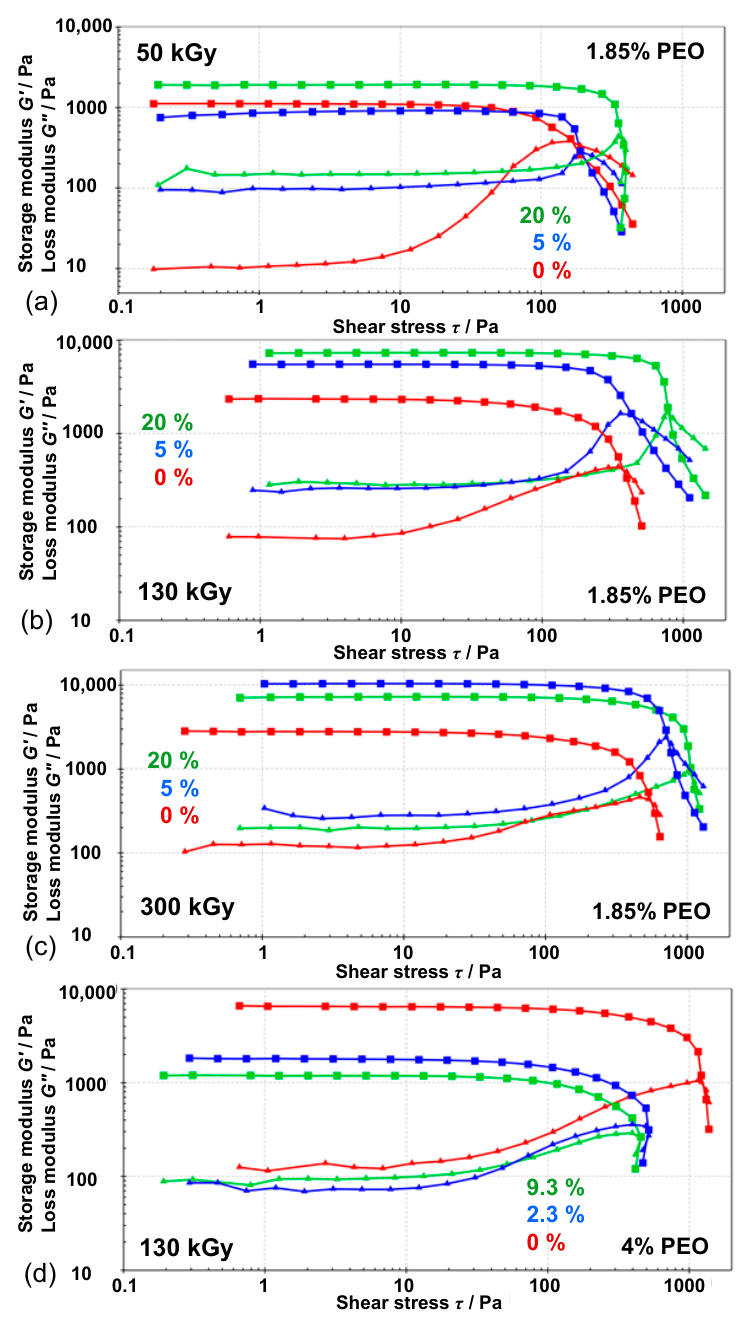
Figure 12. Amplitude sweep test ( G ′ ( ■ ) and G ″ ( ▲ ) values) of pure PEO gels and nanocomposite gels obtained at ( a ) 50 kGy, ( b ) 130 kGy, and ( c ) 300 kGy from 1.85 wt% PEO suspensions, and at ( d ) 130 kGy from 4.0 wt% PEO suspensions, at 25 °C. The initial mass percentage of Fe 3+ (relative to the total PEO and Fe 3+ mass) in precursor suspensions is indicated.